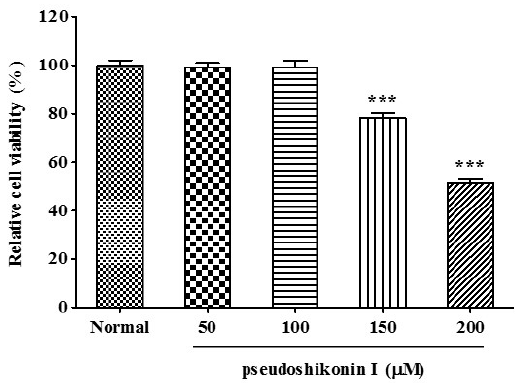
Figure 2. Cell viability of pseudoshikonin I in SW1353 cells. SW1353 cells were treated with indicated concentrations of pseudoshikonin I for 24 h. Normal represents samples only supplied with DMEM and cell viability assay being conducted by the MTT method. Results are expressed as the percentage change of control condition in which cells were grown in medium without pseudoshikonin I. Results shown are mean S.D. of experiments in triplicate. * p < 0.05; ** p < 0.01; *** p < 0.001 compared with control.